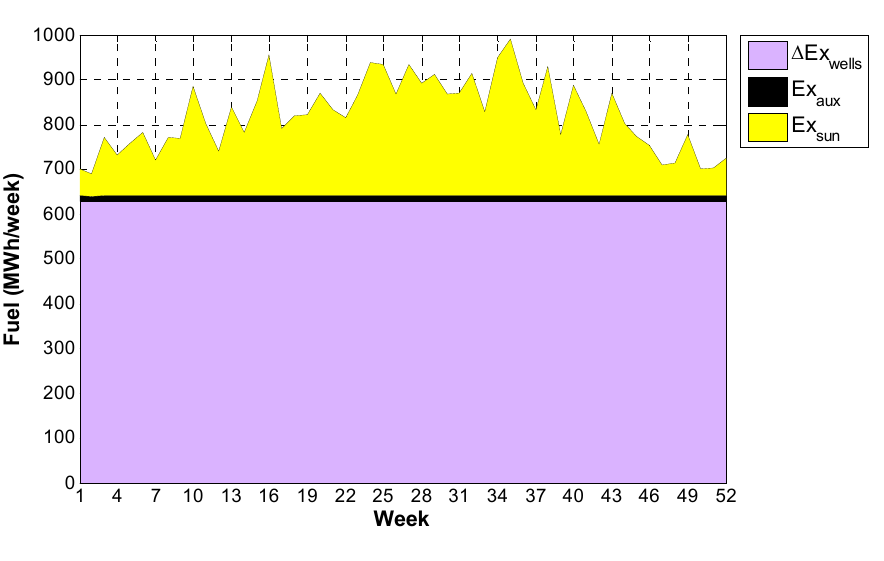
Figure 10. Weekly contribution of the different fuels.